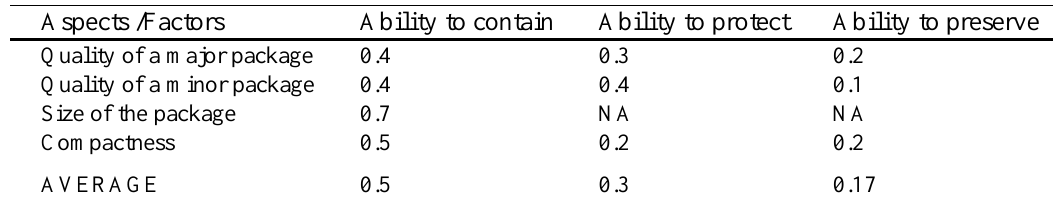
Table 5. Aspects of packaging